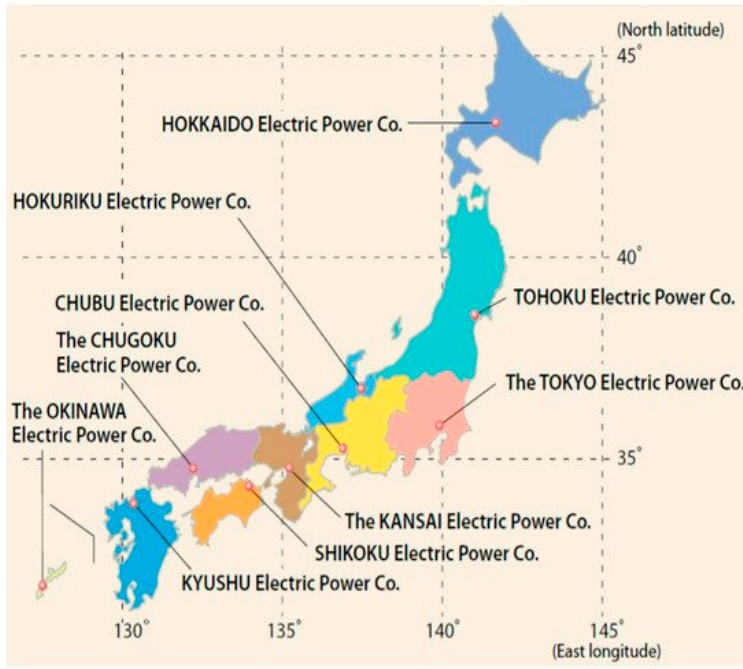
Figure 1. Nine Electric Power companies in Japan. Source: [28].